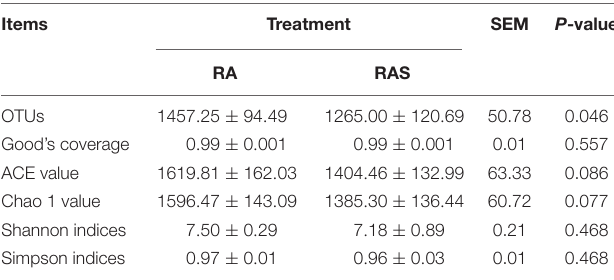
TABLE 4 | Effects of the starter feeding on richness and diversity index of ruminal microbiota in yak calves. Items Treatment